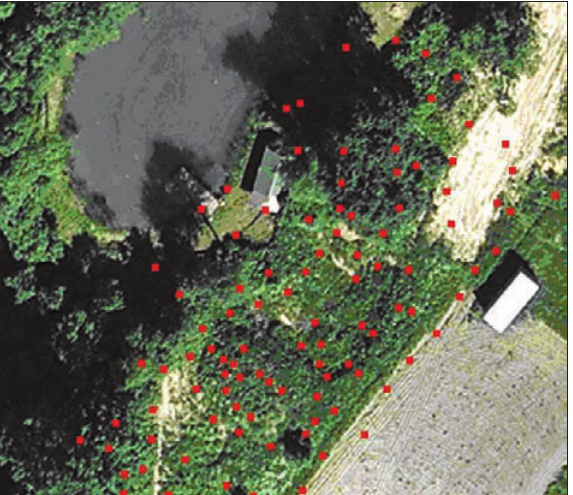
Fig. 3. LIDAR points on field with brushes and trees (Kaunas)